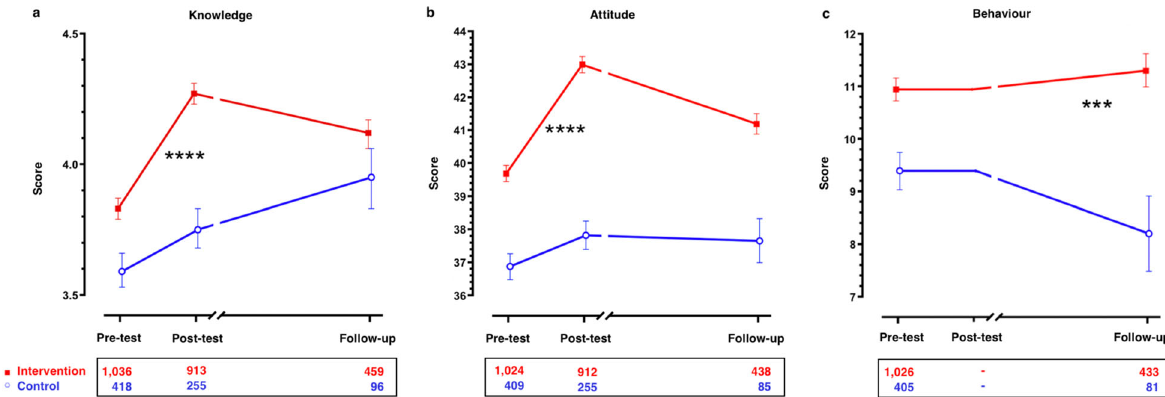
Fig. 2 Participants ’ knowledge, attitude and behaviour on research integrity and misconduct. Pre-test indicates scores immediately prior to a 3-h course on research integrity (intervention) or another course (controls). Post-test indicates scores immediately after the course. Follow-up indicates scores after 3 months. a Sum of six knowledge items (minimum 0, maximum 6). b Sum of ten attitudes items (minimum 10, maximum 50). c Sum of fi ve behaviour items (minimum 5, maximum 15), behaviour questions were not asked at post-test. Data are shown as means with 95% con fi dence intervals. *** P < 0.001, **** P < 0.0001 for the differences in change with respect to pre-test values between both groups, as determined by multivariate linear models for longitudinal measurements, using a direct likelihood approach. Numbers of respondents are indicated below the graphs and may differ from those shown in Fig. 1 because of missing data. For details, see Table